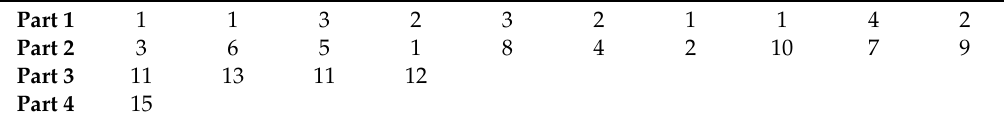
Table 2. Schematic illustration of the decoding example.